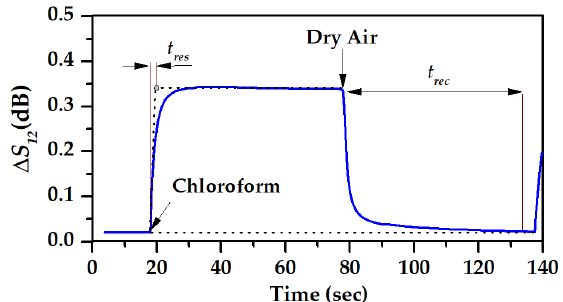
Figure 16. Time dependence of ∆ S 12 during the admission of saturated chloroform vapors and further blowing with dry air.